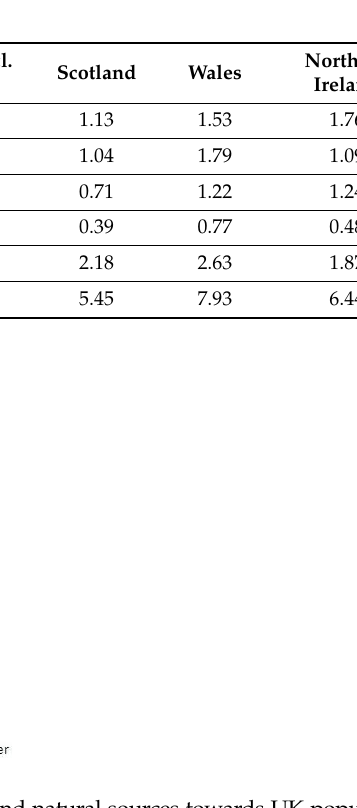
Figure 4. Contribution of national (UK), transboundary, and natural sources towards UK population-weighted mean concentrations of PM 2.5 in the UK in 2018. See Table 1 for contributions to de- volved regions.